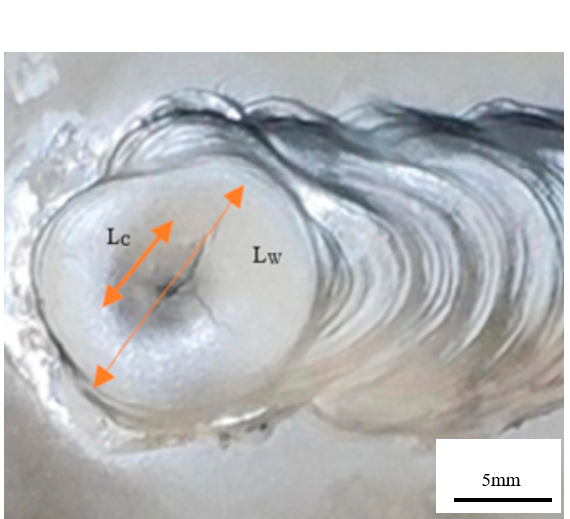
Figure 2. Processing sample map of the crack rate measurement